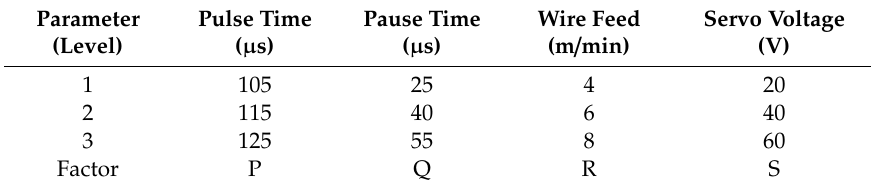
Table 1. Process parameters and their levels.